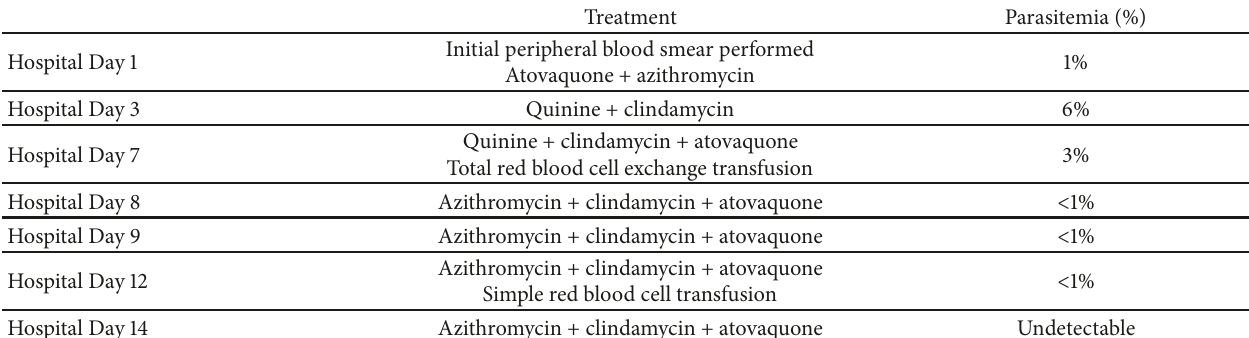
Table 1: Percentage of Babesia parasitemia during the course of